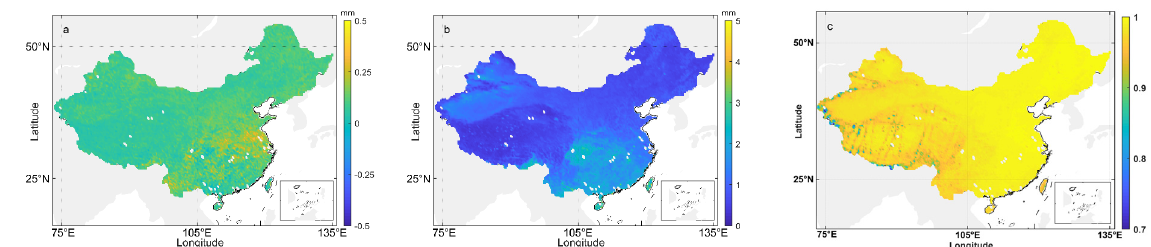
Figure 12. ( a ) Bias, ( b ) RMS, and ( c ) correlation coefficient between ERA-PWV and calibrated MOD-NIR-PWV in the six- year period studied over each grid point.